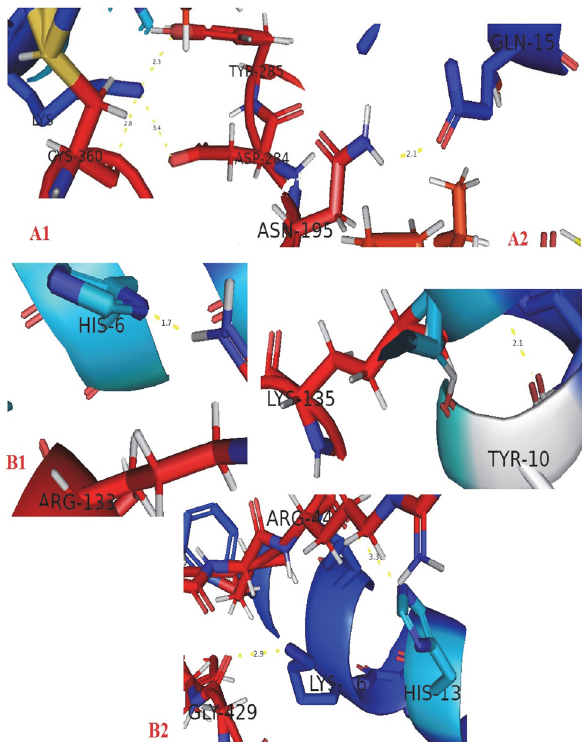
Figure 10. The SOAP and IES model results of Aggregatin and Aβ 28 peptides. A1.) Aggregatin (ASP284, TYR285, CYS360) interacts with the residue of LYS16 of Aβ 28. A2.) The interaction is between Aggregatin(ASN195) and GLN15 of Aβ 28. B1.) The docking is be- tween the residue of Aggregatin(ARG133)-HIS6(Aβ 28 ) and LYS135-TYR10. B2.) In the binding mode, Aggregatin(GLY447) interacts with the residue of HIS13 and GLY429 with LYS16 of Aβ 28 . In this simulation, TYR10, HIS13, and LYS16, and HIS6 residues are common to both Aβ 28 and Aβ 42 in docking